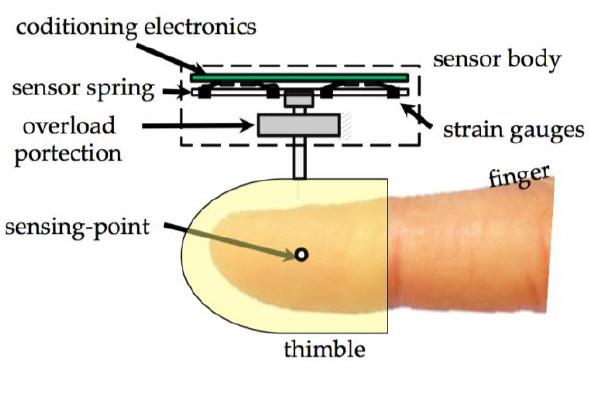
Figure 2. Layout and location of the force sensor respect to the user finger and scheme of internal structure of the components of the force